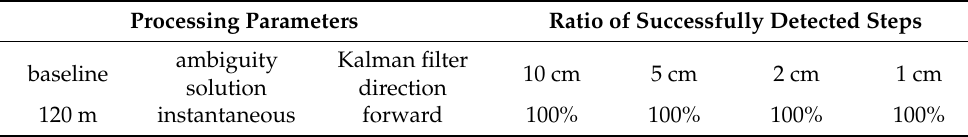
Figure 16. Automated tiny shift detection based on deformation. The antenna was quickly moved repeatedly 5 mm distance per step. The blue dot line is the apparent displacement derived from the short baseline solution. The red line is the deformation after applying the moving average filter method.